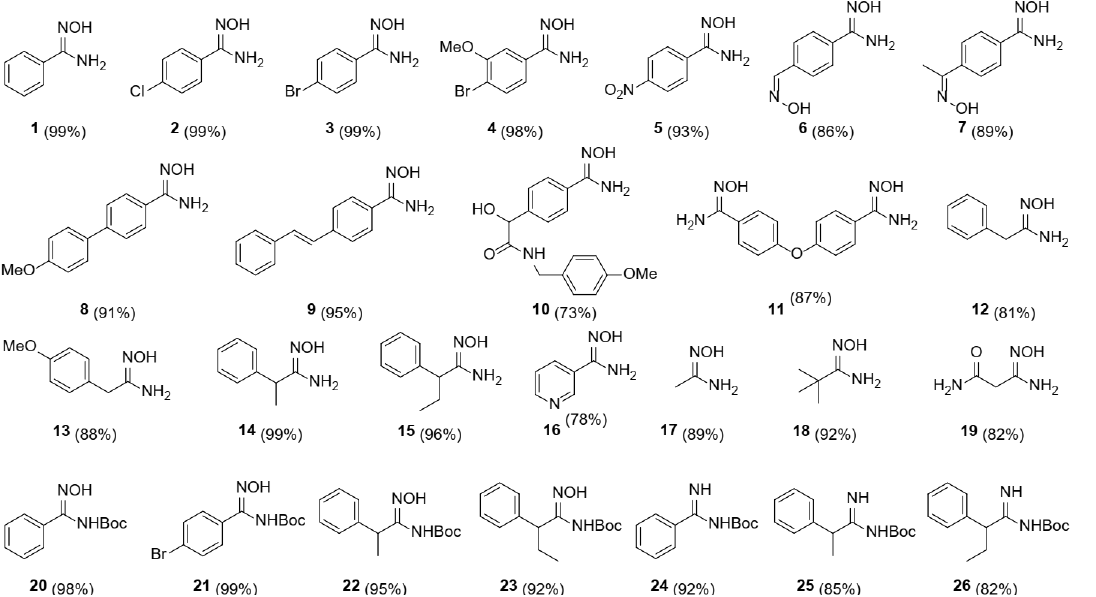
Figure 2. The chemical structures of the obtained amidine derivatives 1 – 26 . Yields are provided in brackets.